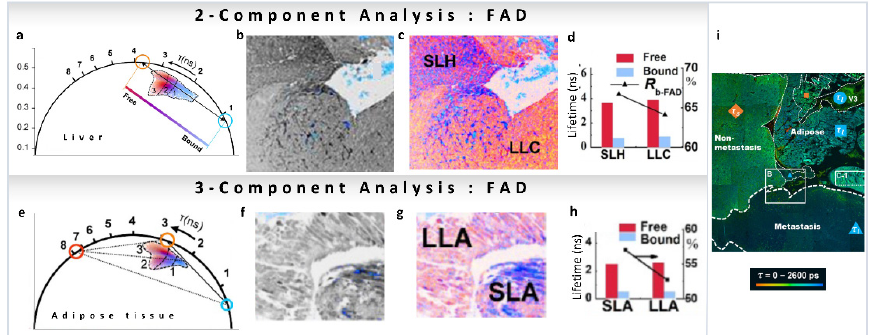
Figure 9. ( a – e ). Metabolic imaging of FAD using multiple components. FAD FLIM data of hepato- cytes and cancer cells of metastatic pancreatic cancer (panels adapted with permission from [48]). ( a ) Phasor plot showing linear combination of two components, short lifetime (protein-bound FAD, blue cursor) and long-lifetime (free FAD, orange cursor). ( b ) Grayscale (accumulated photon counts) of hepatic cells. ( c ) Pseudo-color image showing different lifetime species in the short-lifetime hepatocytes (SLH) and long-lifetime cancer cells (LLC). ( d ) Lifetimes and ratios ( Rb-FAD ) of the components. ( e , f ) FAD FLIM data of adipocytes of metastatic pancreatic cancer. ( e ) Phasor plot showing three-component analysis, short lifetime (protein-bound FAD, blue cursor), long-lifetime (free FAD, orange cursor) and another much longer lifetime component (red cursor). ( f ) Grayscale (accumulated photon counts) of adipose cells. ( g ) Pseudo-color image showing different lifetime species in the short-lifetime adipose (SLA) and long-lifetime adipose cells (LLA). ( h ) Lifetimes and ratios ( Rb-FAD ) of the components. FLIM. (Panels adapted with permission from